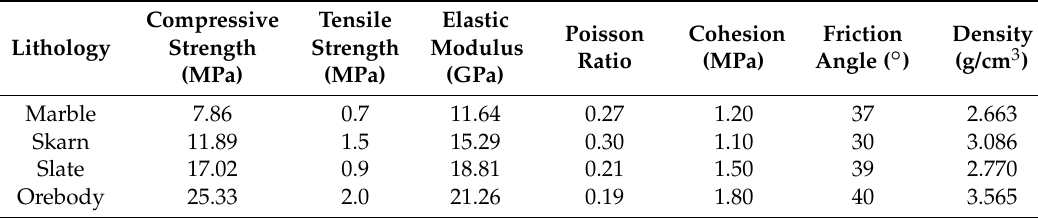
Table 1. Rock mass mechanical parameters.